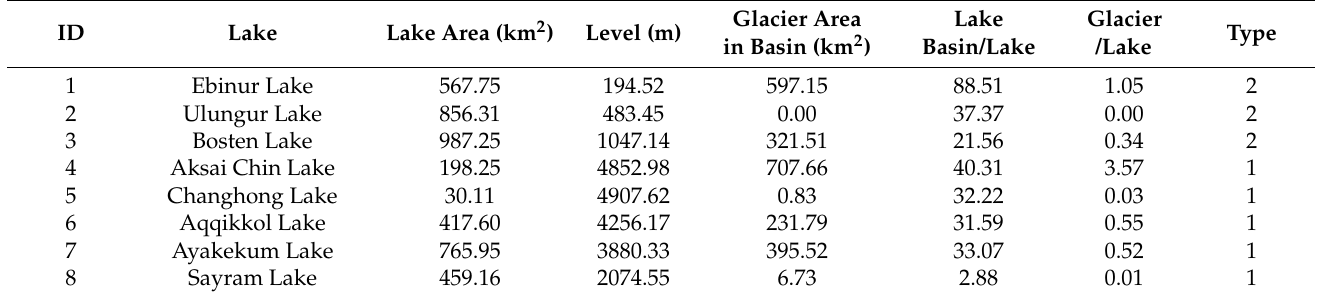
Table 1. Variations in water levels and lake area of eight typical lakes in Xinjiang (the lake type is coded as “1 (cid:48) ’ for alpine lakes and “2 (cid:48) ’ for non-alpine